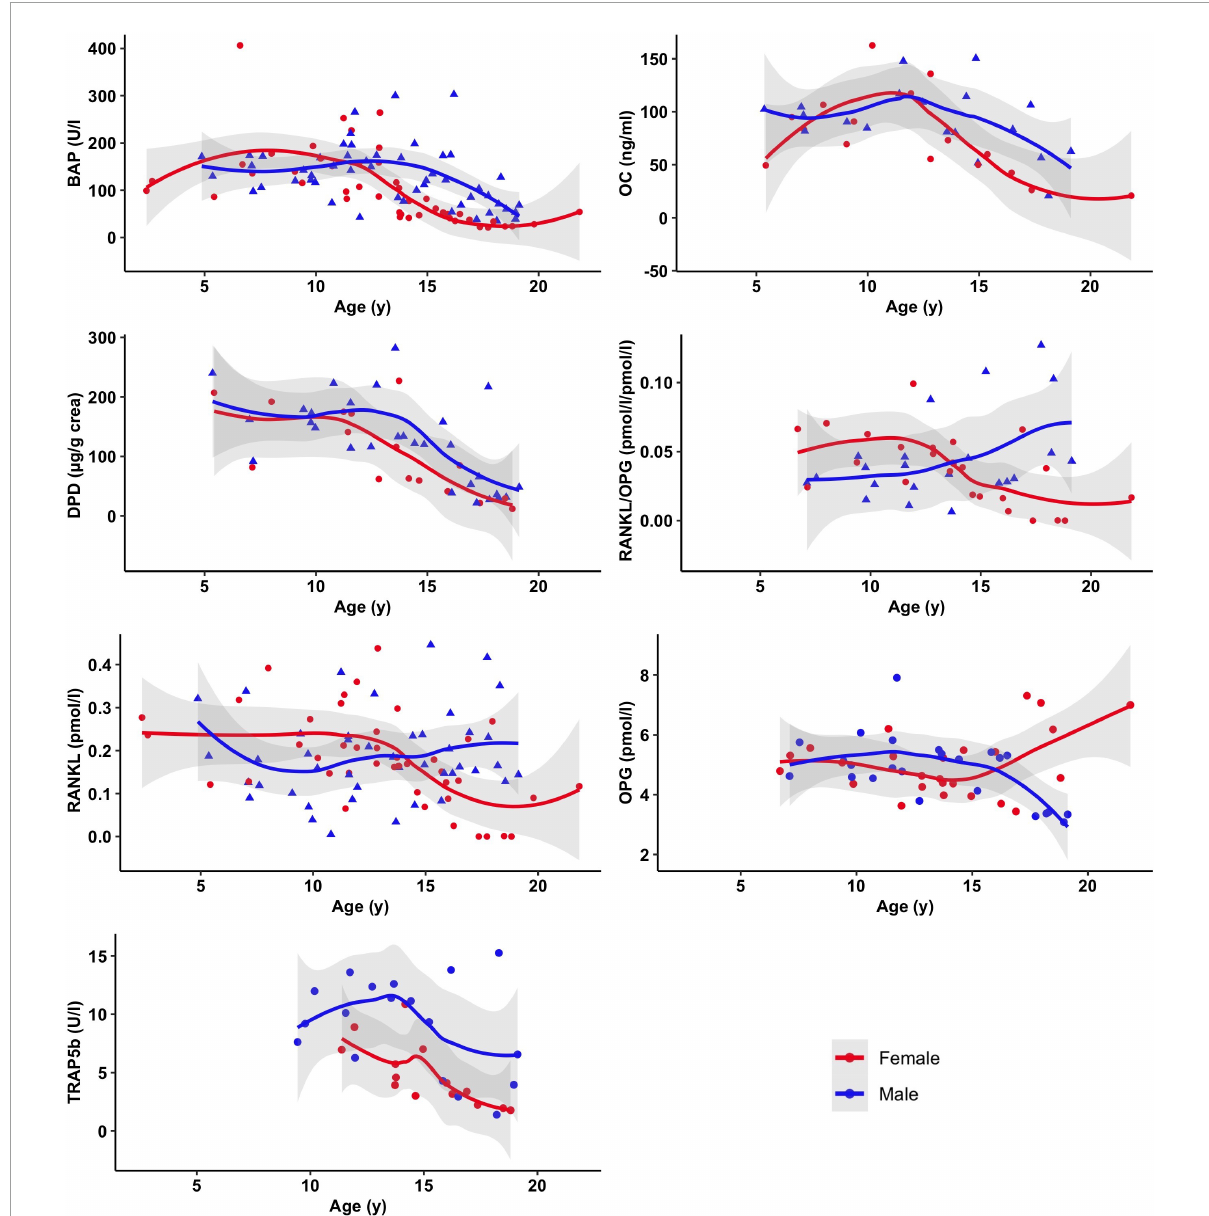
FIGURE1 Selected markers of bone metabolism as a function of age and sex. Displayed are mean and 95% confidence band of SE of smoothed curves by local polynomial